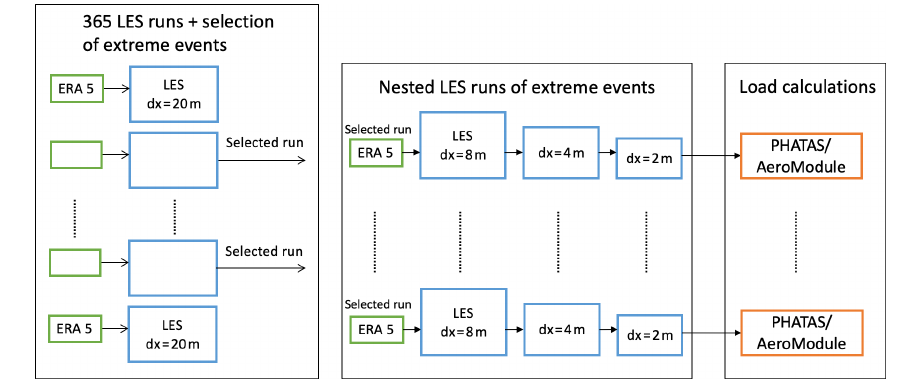
Figure 1. Schematic representation of the experimental set-up. From 365 LES runs for a North Sea location, five extreme events are selected. These are re-run on higher resolution and the output passed to the aeroelastic models PHATAS and